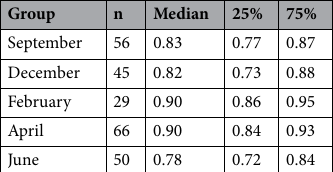
Table 3. Median MC (%) measured in each month of sampling. Sample size (n) is also